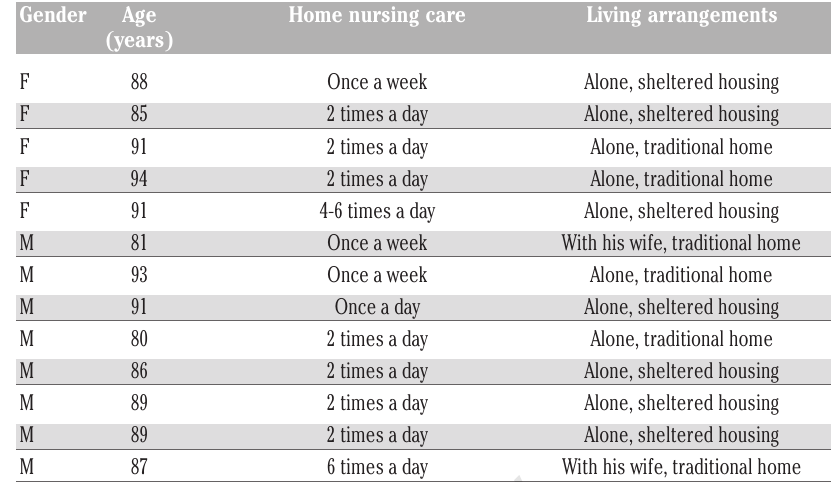
Table 1. Study subjects gender, age, assistance from home nursing care and living